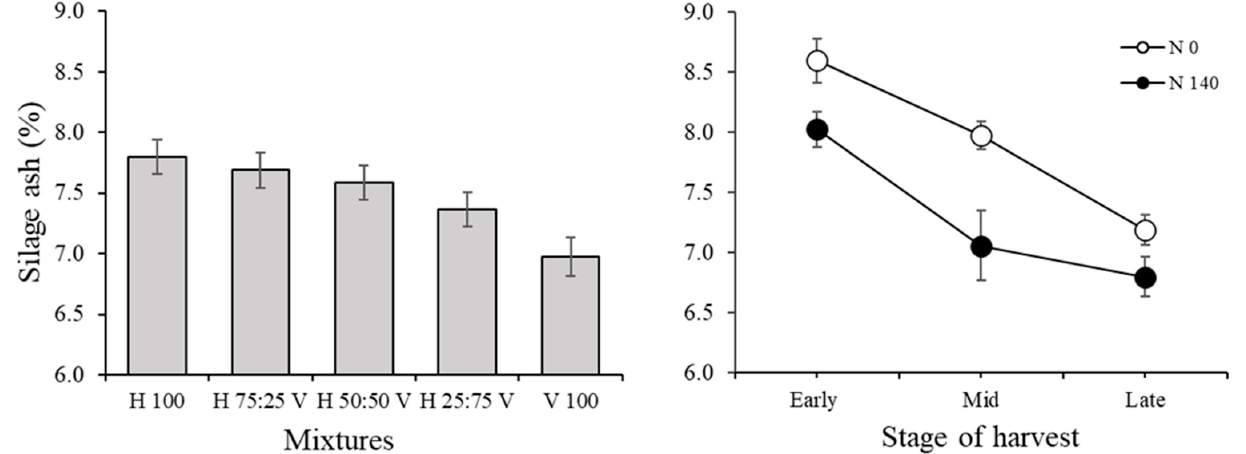
Figure 10. Silage ash concentration as affected by MX mean effect ( left ) and SH × NF interaction ( right ). On the left, values are LSmeans across all treatments along with standard error estimate of the LSmeans since the design was unbalanced between the faba bean crop ( n = 9) compared to the mixtures and the barley crops ( n = 18). On the right, only data of the barley-containing treatments were used. Each point represents the arithmetic mean ( n = 24) and its computed standard error.